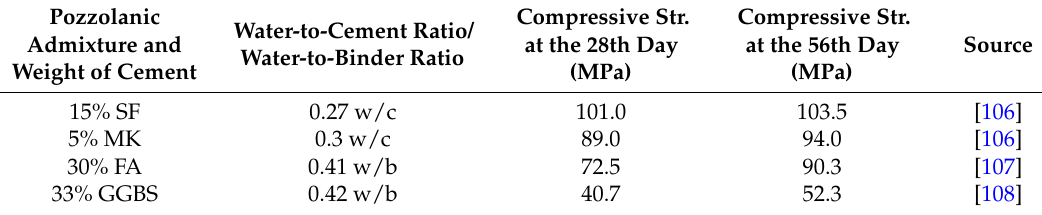
Table 3. Examples of mechanical properties of